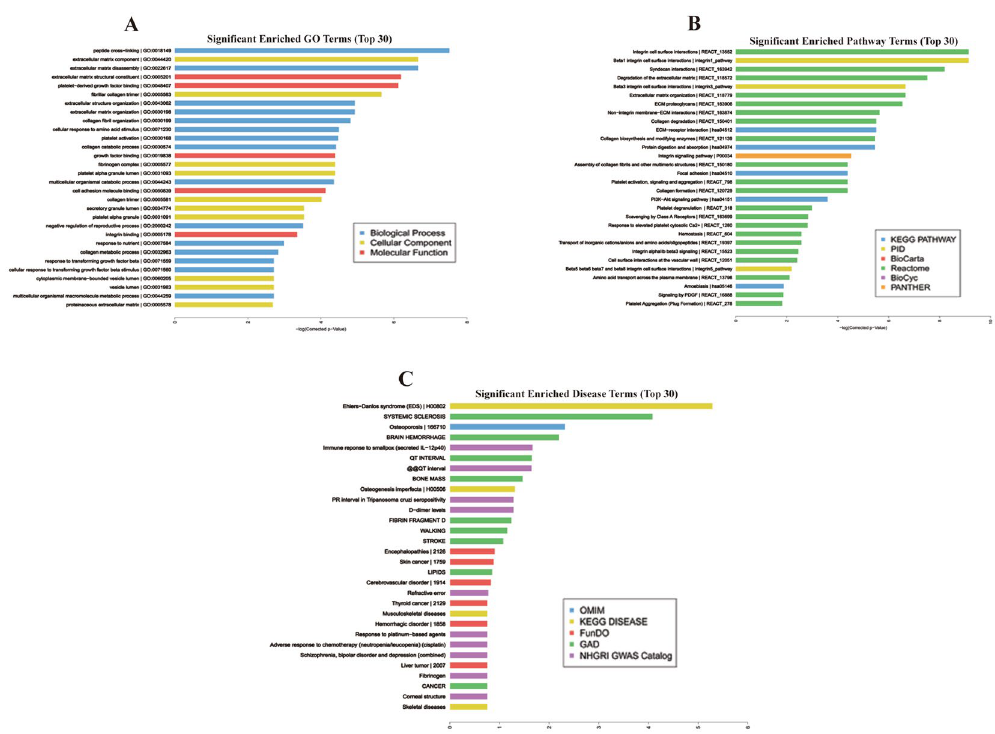
Figure 3. Results of Gene Ontology, KEGG pathway, and disease enrichment analysis. ( A ) Top 30 classes of GO enrichment terms. (B) Top 30 classes of KEGG pathway enrichment terms. (C) Top 30 disease enrichment